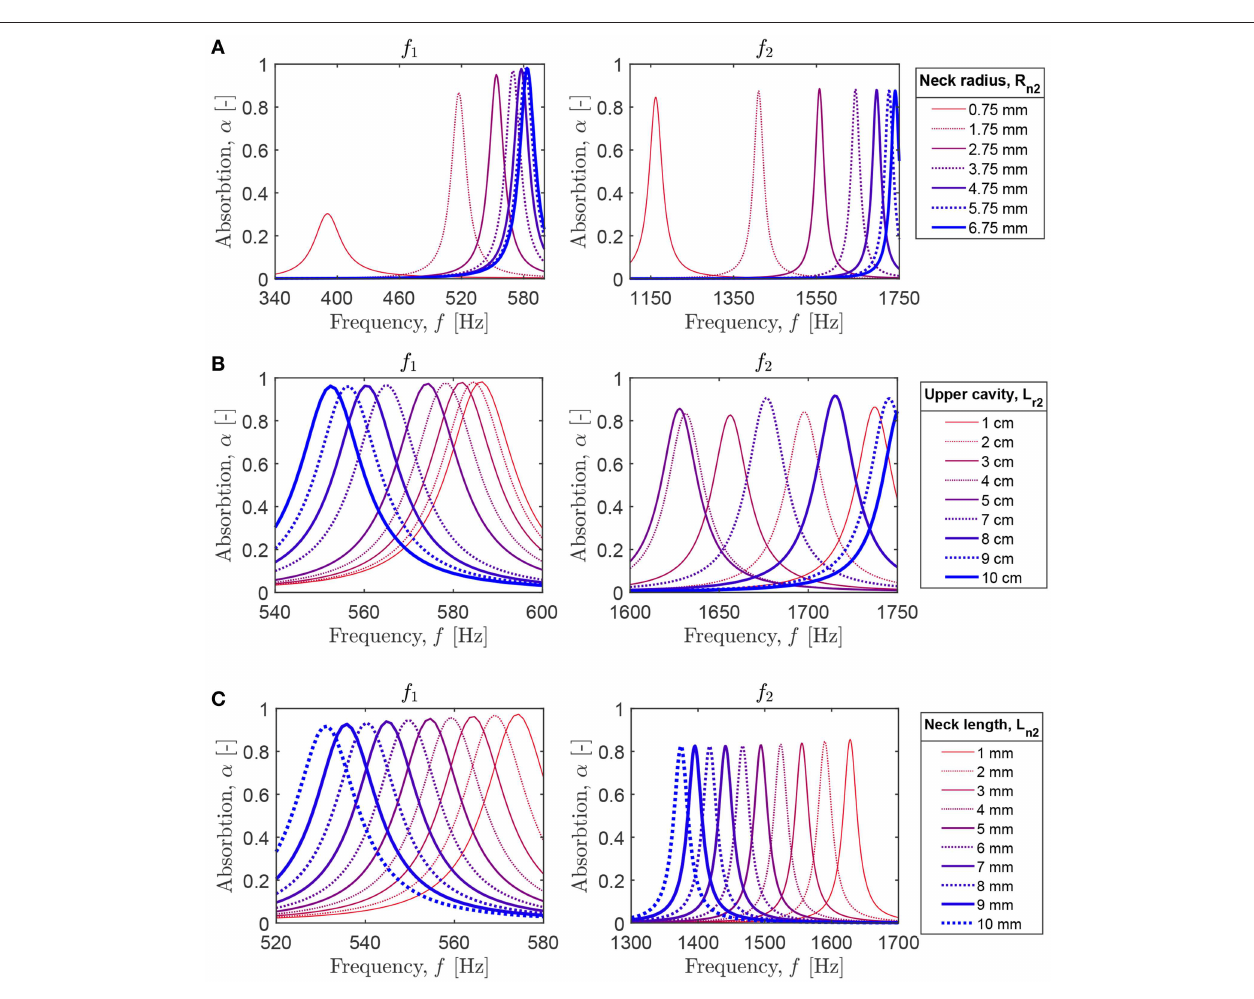
FIGURE 9 | Parametric analysis of the geometry and position of the supplementary neck on the absorption of the panel with the coupled HR: the first (left) and second (right) absorption peaks for the varying (A) radius of the neck; (B) length of the upper HR cavity; (C) length of the